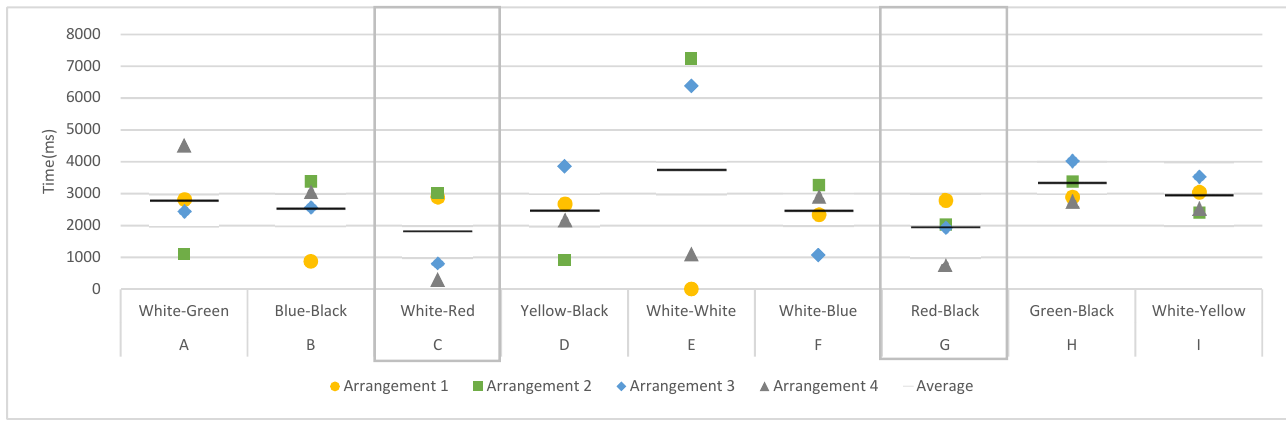
Figure 3. Entry Time in Different Door-Frame Combinations.